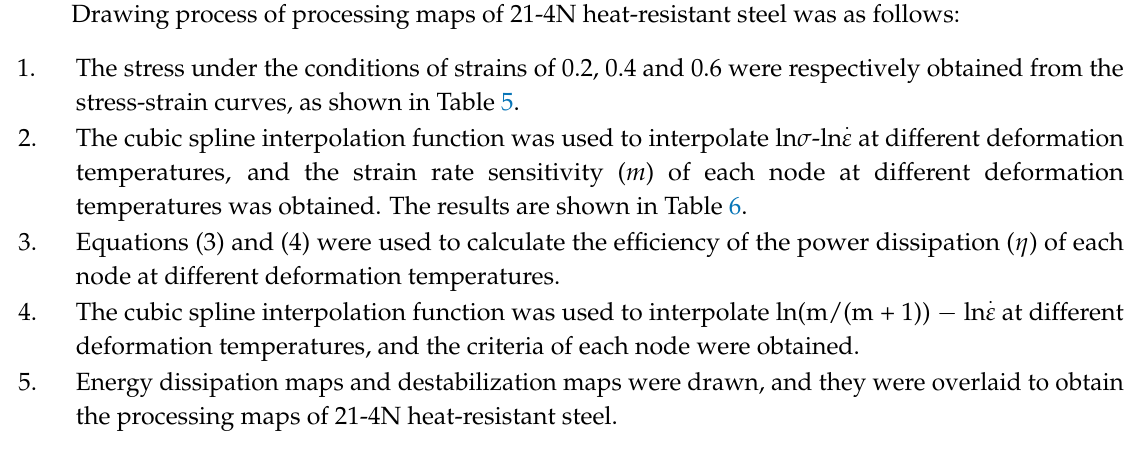
In the equation: E —Peak stress experimental value; P —Peak stress prediction value (calculated value); Equation (12) was used to calculate Z at different temperatures and strain rates. Then, the results were substituted into peak stress constitutive Equation (16), and the corresponding rheological stress was calculated, as shown in Table 3. Table 3. The calculated rheological stress ( σ ) of 21-4N steel under different hot deformation conditions (MPa).